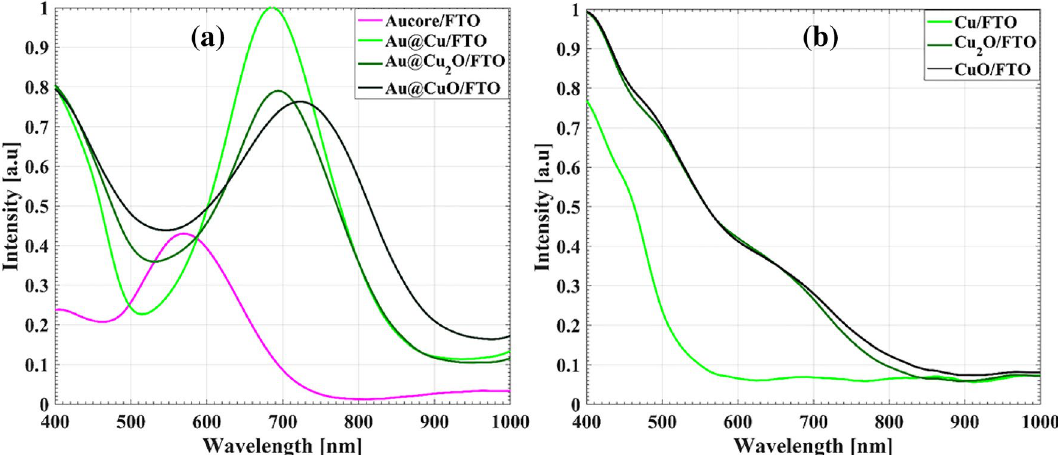
Figure 4. Vis–NIR spectrum of ( a ) Aucore supported FTO electrode, Au@cu, Au@cu 2 O and Au@CuO FTO electrodes and ( b ) Cu/FTO, Cu 2 O/FTO and CuO/FTO